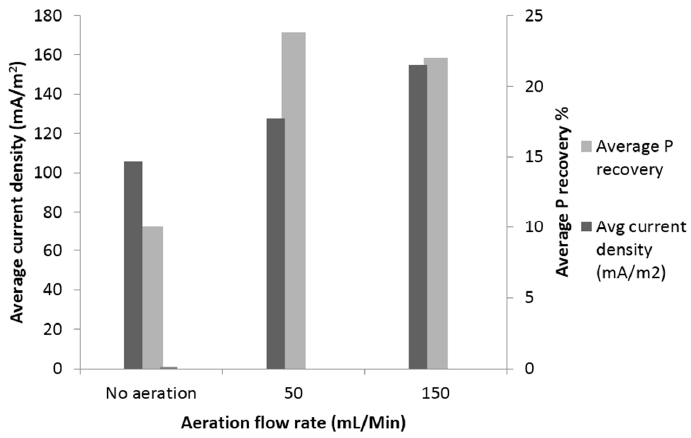
Figure 9. Impact of aeration flow rate on energy generation and P recovery.